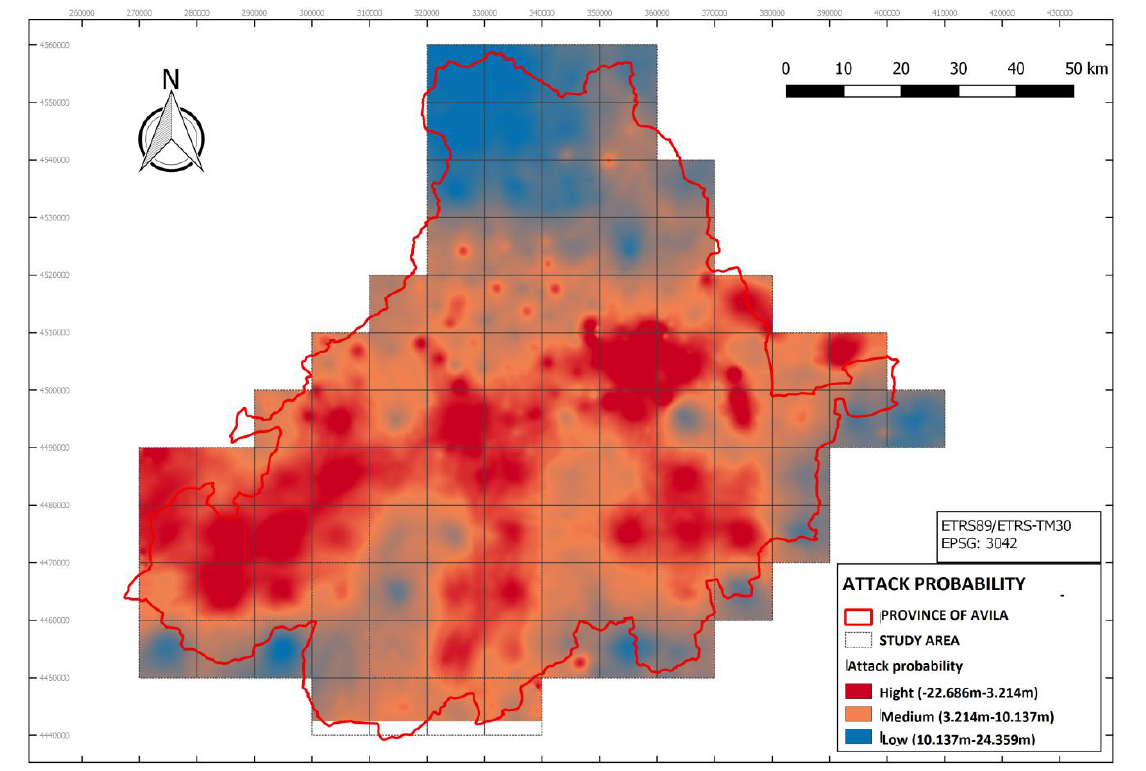
Figure 3. Map of the probability of attack of Iberian wolf on livestock according to the model developed in the study area.